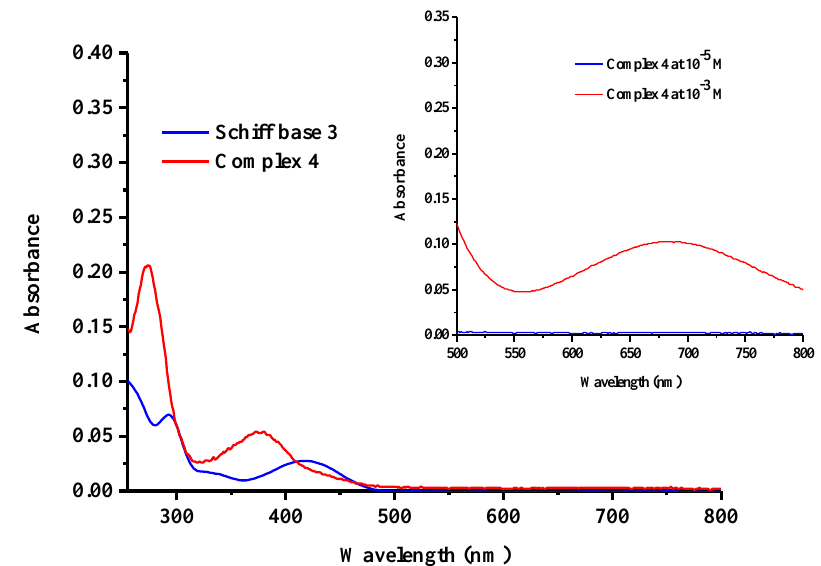
Figure 2. UV-Vis spectra of the Schiff base 3 (blue line) and complex 4 (red line) in MeOH at a concentration of 10 − 5 M. The inset graph presents the d-d transitions observed in MeOH at a concentration of 10 − 3 M.